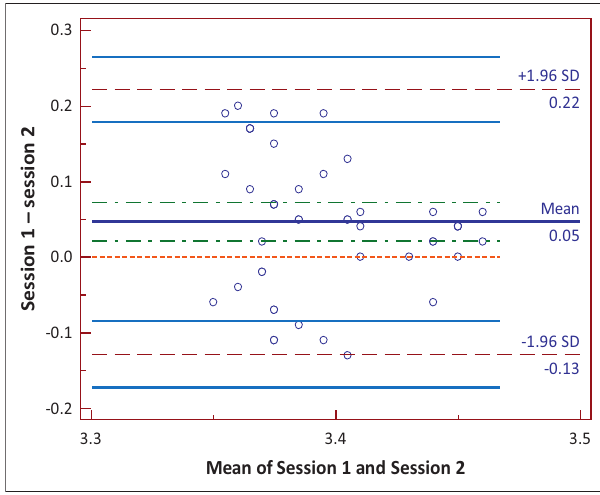
FIGURE 3: Bland-Altman plot for lens thickness measurements (in mm) taken during sessions 1 and 2 for Subject 3. TABLE 2: Mean differences from Bland-Altman plots with 95 % lower and upper limits of agreement (LoA) alongside respective means for each subject.